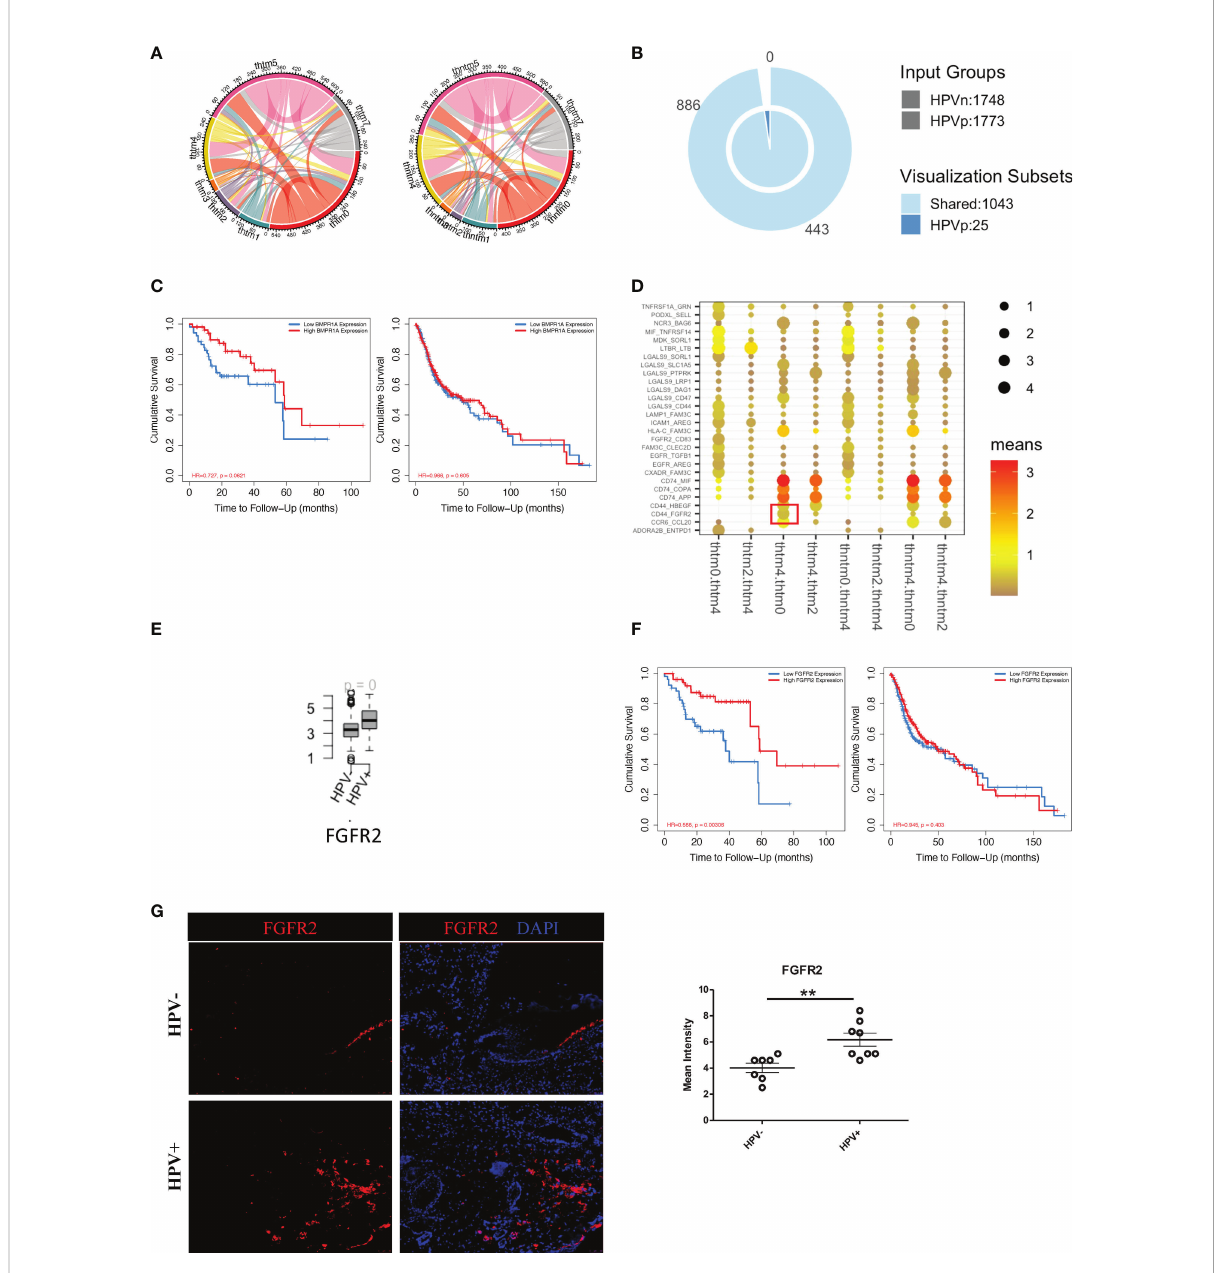
FIGURE 5 Cell communication between immune cells and HPV + tumour cells. (A) A network of interactions between immune and either HPV + or HPV - tumour cells. The lines represent the pointing relationships. (B) A Venn diagram showing the shared and unique cell-cell interactions of immune cells with HPV + or HPV - tumour cells. (C) Kaplan-Meier survival analysis of BMPR1A in the HPV + and HPV - HNSCC patients. (D) Dot plots showing the most signi fi cant interactions of B cells with either HPV + or HPV - tumour cells and the signi fi cance of their relationships. The horizontal coordinates are cell-type interactions and the vertical coordinates are protein interactions, with the larger dots indicating smaller p- values and the colours representing the average expression. (E) Boxplots showing the gene expression of FGFR2 in the HPV + and HPV - HNSCC patients. p=0 refers to p<0.0001. (F) Kaplan-Meier survival analysis of FGFR2 in the HPV + and HPV - HNSCC patients. (G) Representative immuno-stained photomicrographs of FGFR2 in surgical sections obtained from patients with HPV + and HPV - HNSCC. The data are means ± SD of 7 experiments and were analysed using Student ’ s t test;